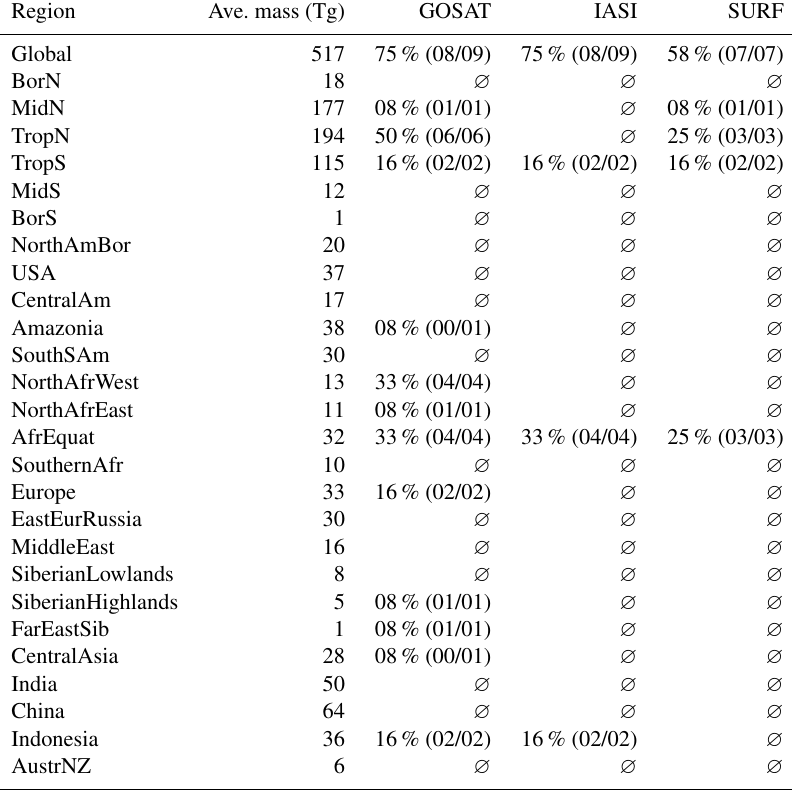
Table 2. Detection of the signal consisting in the anomalies at the yearly timescale. The signal is the difference between each year in the 2000–2011 period (i.e., 12 occurrences) and the 2004–2005 average from REFSURF. The noise is computed at the yearly timescale from each of the three observation systems, GOSAT, IASI and SURF. See Sects. 2.4 and 2.3 for details. In each cell of the table, we show X % ( YY/ZZ ) where X % is the percentage of yearly anomalies detected (among 12 possible), YY is the number of positive anomalies detected among the ZZ detected anomalies. Column labeled Ave. mass indicates the average emitted mass of CH 4 over 2004–2005 in the